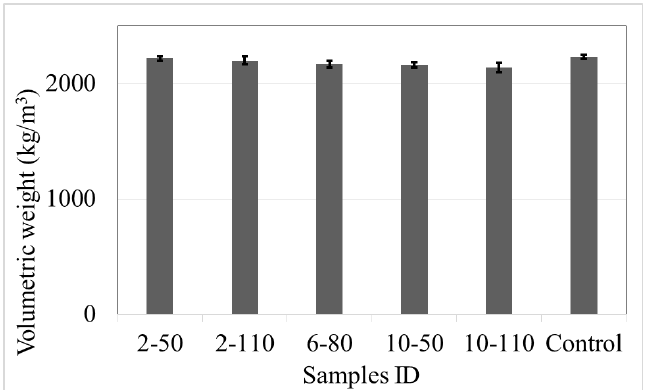
Figure 18. Volumetric weight of control samples and concrete with recycled PET fibres.